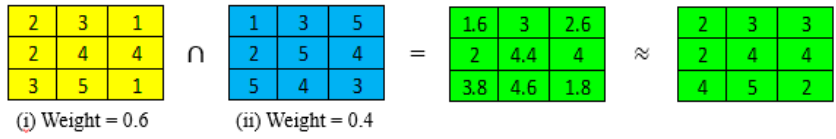
Figure 3. A sample calculation showing the utility of the Weighted Overlay Tool.